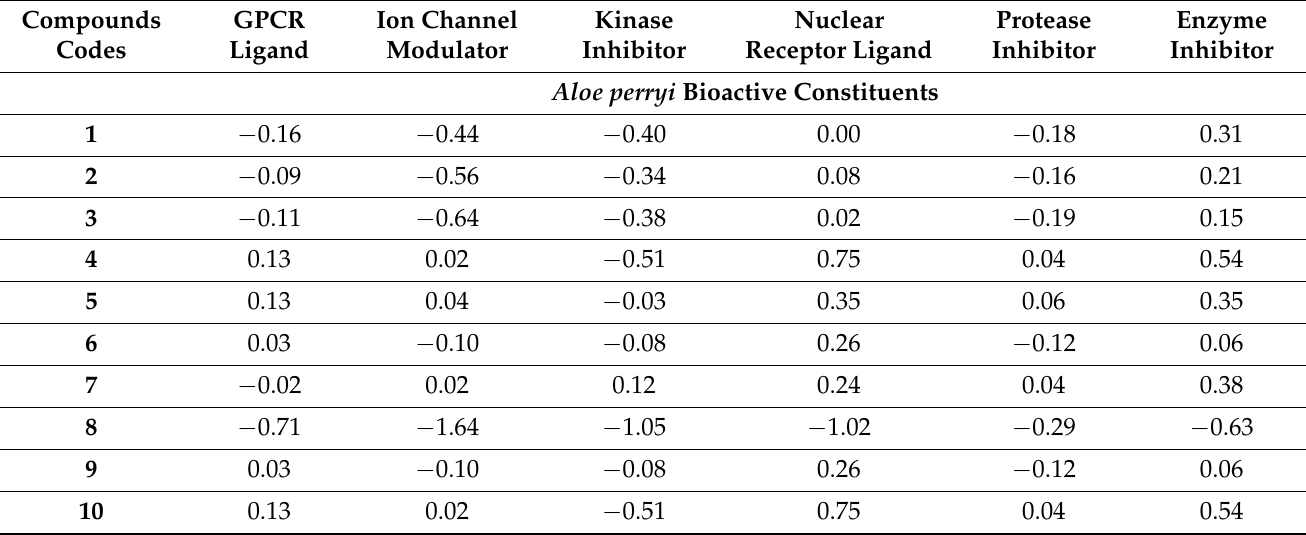
Table 5. Target predictions of the active constituents in Aloe perryi